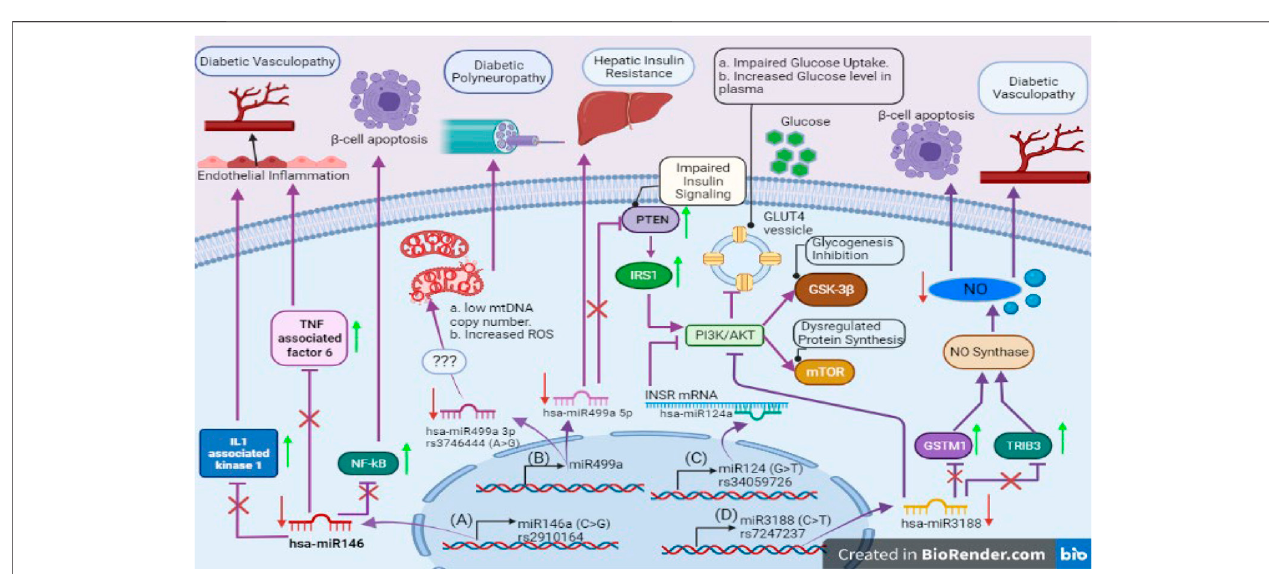
FIGURE 3 | SNPs reported in seed sequence of miRNA involved in diabetes: (A) miR146a with SNP rs2910164 (C > G) raises vascular complications caused by upregulation of in fl ammatory factors (TNF associated factor 6 and IL1 associated kinase 1) in endothelial cells and induces apoptosis in pancreatic β -cells via NF-kB mediated pathway. (B) Reduced expression of miR499a due to SNP rs3746444 (A > G) provokes mitochondrial stress, impairs insulin signaling via PTEN mediated pathway, and promotes hepatic insulin resistance. (C) The miR124 rs34059726 (G > T) creates complimentary sequence for INSR; causing failure to transport GLUT4 transporter vesicle to outer membrane. This SNP also inhibits glycogenesis process via GSK-3 β activation. (D) miR-3188 with rs7247237 (C > T) inhibits PI3K/ AKT pathway dysregulating protein synthesis. Its target genes overexpression (GSTM1 and TRIB3) curtailsnitric oxide pathway which increases vascular complications and induces β -cell